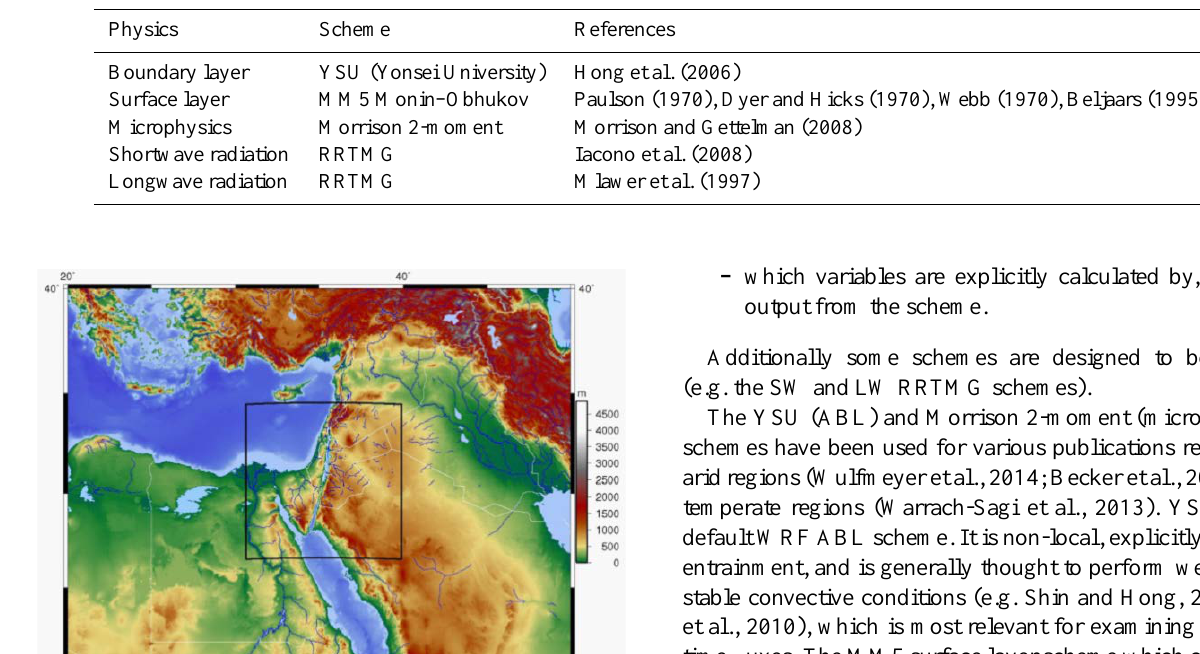
Table 2. Physics schemes used for the study within the WRF atmospheric model.